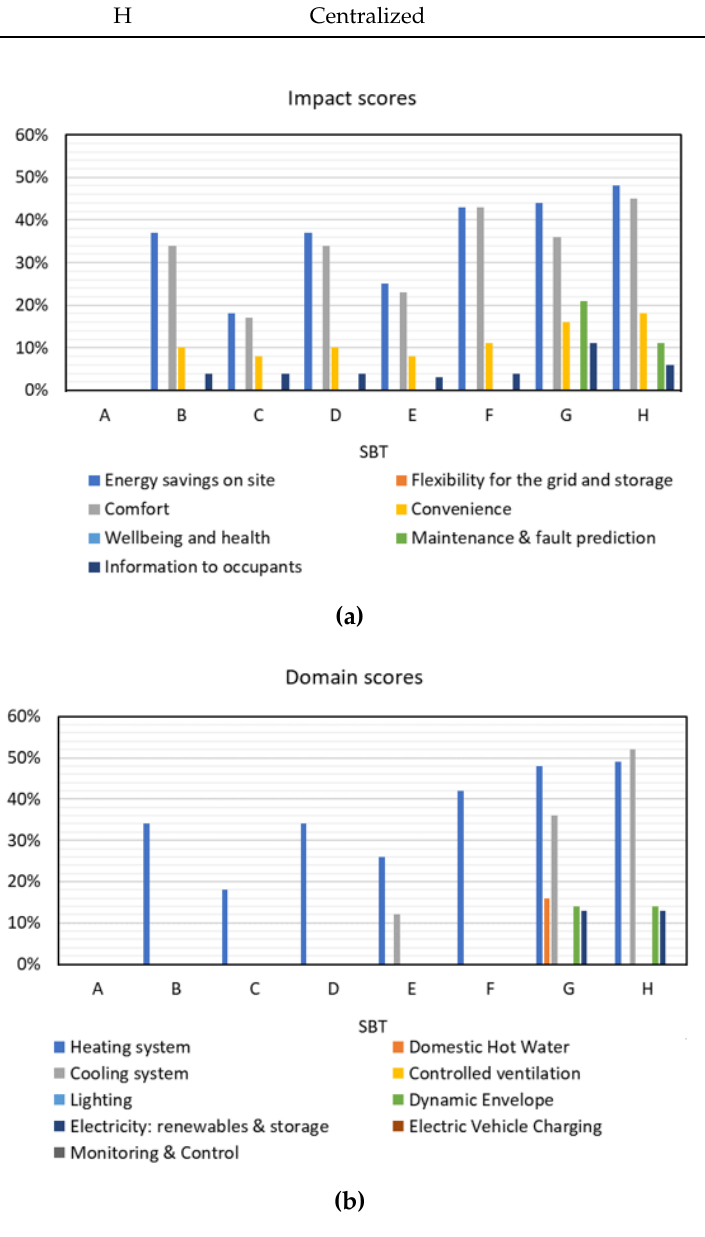
Figure 4. Impact and domain scores for each SBT in the base scenario. ( a ) Impact scores and ( b ) domain scores. ( b ) domain